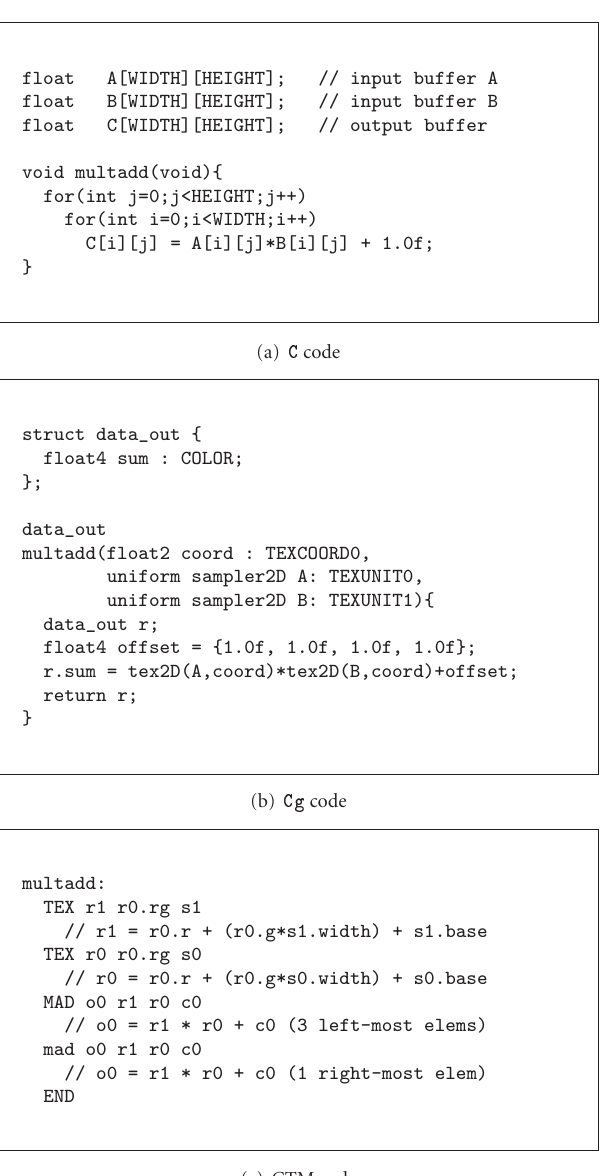
, (b) , and (c) CTM code. (cid:0) (cid:0)(cid:2)